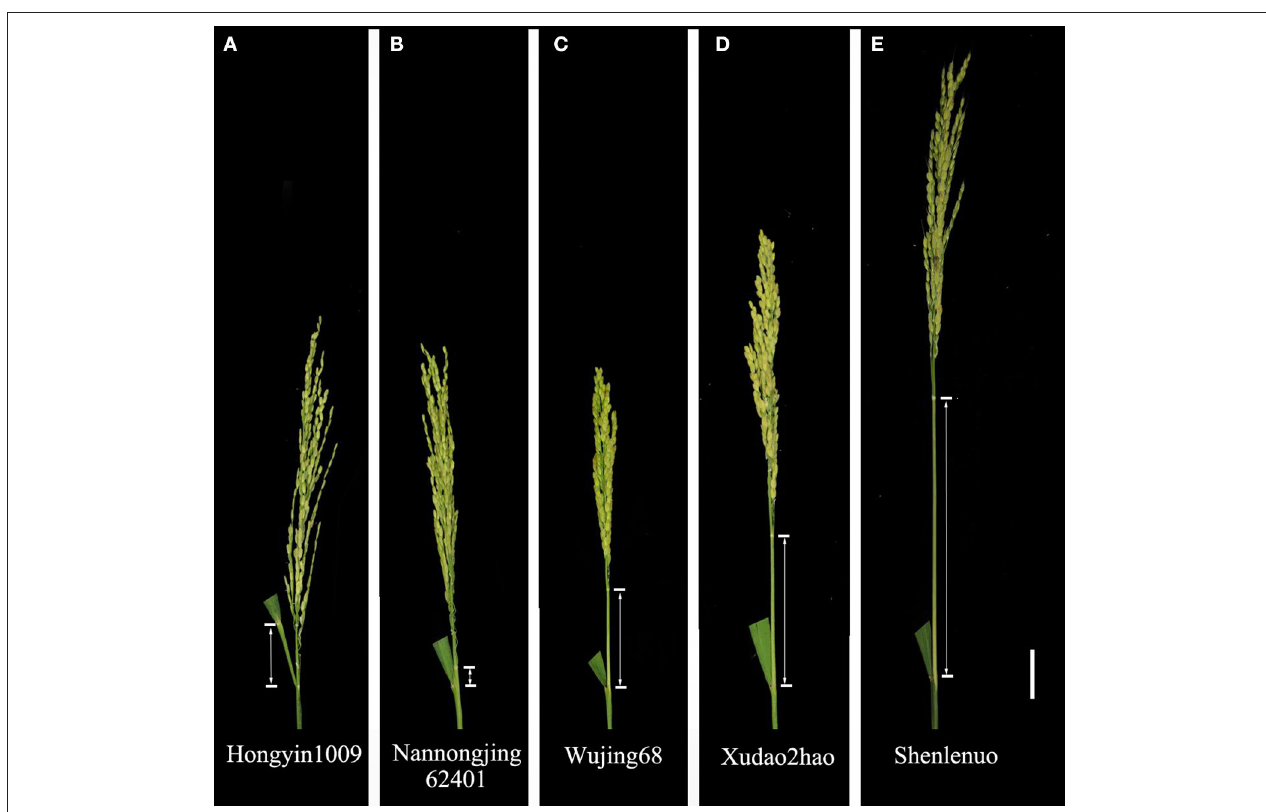
FIGURE 3 | Morphology of the panicle showing the PEL in rice. (A) Panicle of accession Hongyin 1009, showing a minimum value of the PEL. (B) Panicle of accession Nannongjing 62401. (C) Panicle of accession Wujing 68. (D) Panicle of accession Xudao 2hao. (E) Panicle of accession Shenlenuo, showing a maximum value of the PEL. Scale bar,